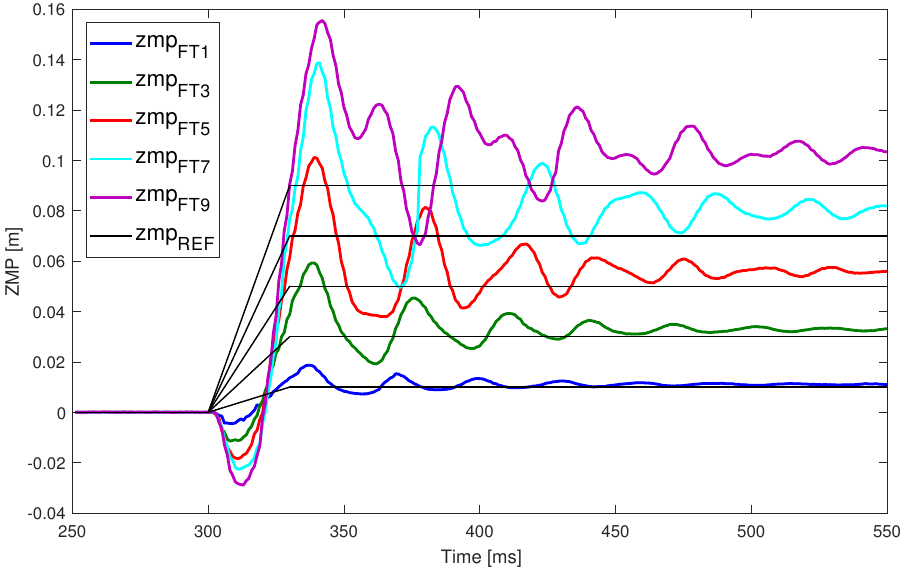
Figure 14. Step response